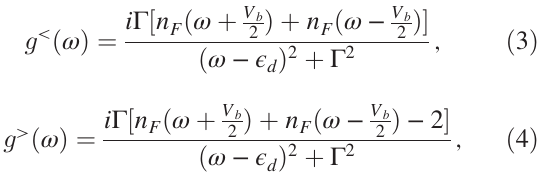
Fig. 1. Here, ϵ is the on-site energy of the impurity d (relative to the particle-hole symmetric point), and ˆ n σ ¼ ˆ c † ˆ c σ electrons. ˆ c † and 0 ; σ is the impurity density of spin 0 ; σ i; σ ˆ c are the creation and annihilation operators, respectively, i; σ for electrons on site i with spin σ . We use ℏ ¼ e ¼ 1 . θ ð t Þ is the Heaviside function: We switch the interaction on at time t ¼ 0 . Typical calculations are performed for large times so that the system relaxes to its stationary regime. The hopping parameters are given by γ ¼ 1 except for γ 0 ¼ i